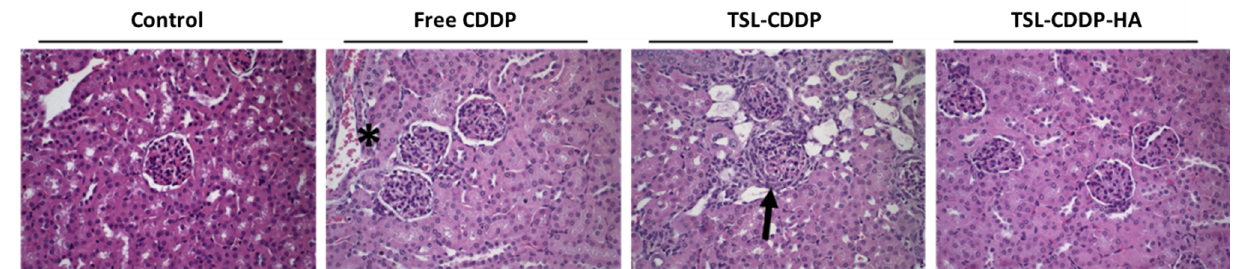
Figure 5. Photomicrographs of kidneys from Swiss mice treated with saline (control), free CDDP, TSL-CDDP and TSL-CDDP-HA. Arrow indicates the thickening of Bowman’s capsule, asterisk indicates inflammatory infiltrate and fibrosis. Hematoxylin & eosin staining. 40× magnification.